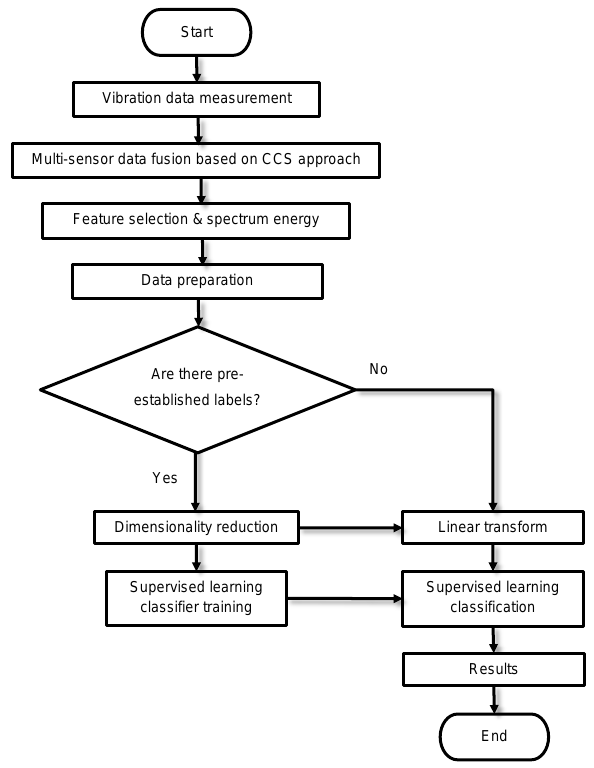
Figure 1. Proposed automated fault classification approach flow chart.